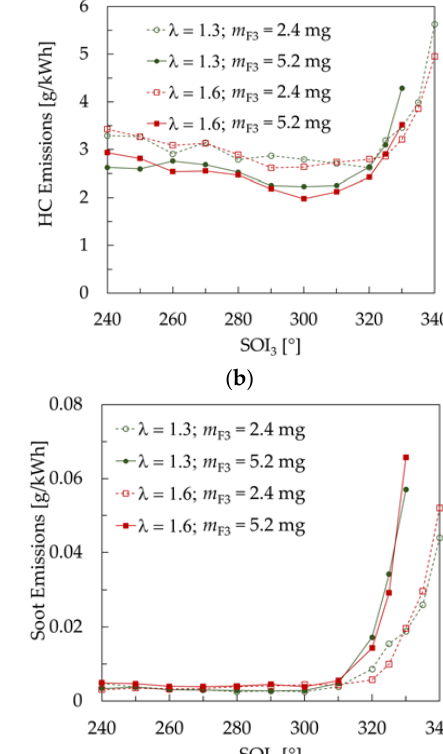
Figure 9. Net indicated thermal efficiency versus SOI 3 timing for all investigated conditions.